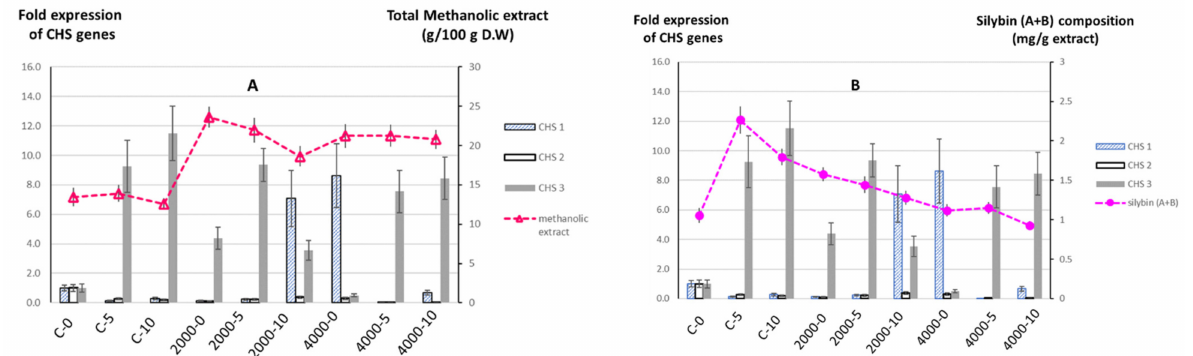
Figure 1. The fold expressions of chalcone synthase (CHS) genes in relation to total methanolic extract ( A ) and silybin (A + B) composition ( B ). The expressions of CHS1, CHS2, and CHS3 for control salinity, without MLE foliar spray (C-0), were normalized as 1. The expressions of the CHS genes for all other treatments (C-5, C-10, 2000-0, 2000-5, 2000-10, 4000-0, 4000-5, and 4000-10) were expressed as fold expressions with respect to the expressions of corresponding genes for C-0 treatment. The amount of methanolic extract was expressed as grams of extract per 100 g of fruit by dry weight, while the silybin composition was measured using high-performance liquid chromatography (HPLC) and expressed as milligrams of silybin (A + B) per gram of methanolic extract. The +/ − bar on the graphs represents the standard error of the corresponding